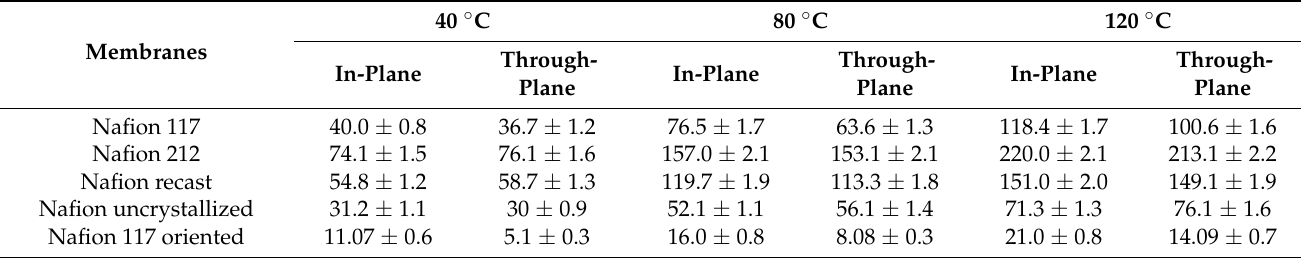
Figure 2. In-plane vs. through-plane proton conductivities of ( a ) Nafion recast, ( b ) Nafion 212; ( c ) Nafion un crystallized and ( d ) Nafion 117 as received and Nafion 117 oriented membranes as a function of temperature (20–120 ◦ C) at 90% RH%. (The error bars are not reported because they are smaller than the size of the symbols). Table 1. Proton conductivity [mS cm − 1 ], @ RH 90% and for three temperature values, of the PFSA membranes (along with the standard deviation resulting from three independent